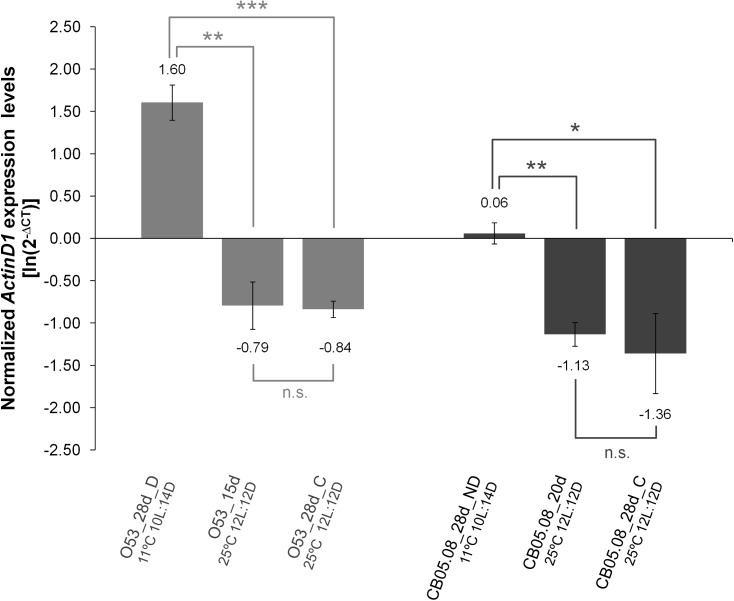

ActinD1 expression level can be used as a marker of ontogenetic delay, which results in extended LS, but it is not a marker of biological age.Differences in ActinD1 gene expression levels were determined between 28 days old diapausing females (O53-D), 15 days old (O53-15d) and control females (O53-C) reared for 28 days under non-diapause inducing conditions (12L:12D at 25°C), as well as between 28 days old non-diapausing females (CB05.08-ND), 20 days old (CB05.08-20d) and controls (CB05.08-C) reared for 28 days under non-diapause inducing conditions (12L:12D at 25°C). The reference gene RpL32 was used to normalize the expression values. Three biological replicates were used for each sample and the averages of the log-transformed values of 2-∆CT are presented with their respective S.E.M.. A two-tailed Student’s t test assuming equal variances was used to address if the averages of normalized ActinD1 expression levels of the different samples and treatments are significantly different (n.s. P > 0.05; * 0.05 > P > 0.01; ** 0.01 > P > 0.001; *** P < 0.001).